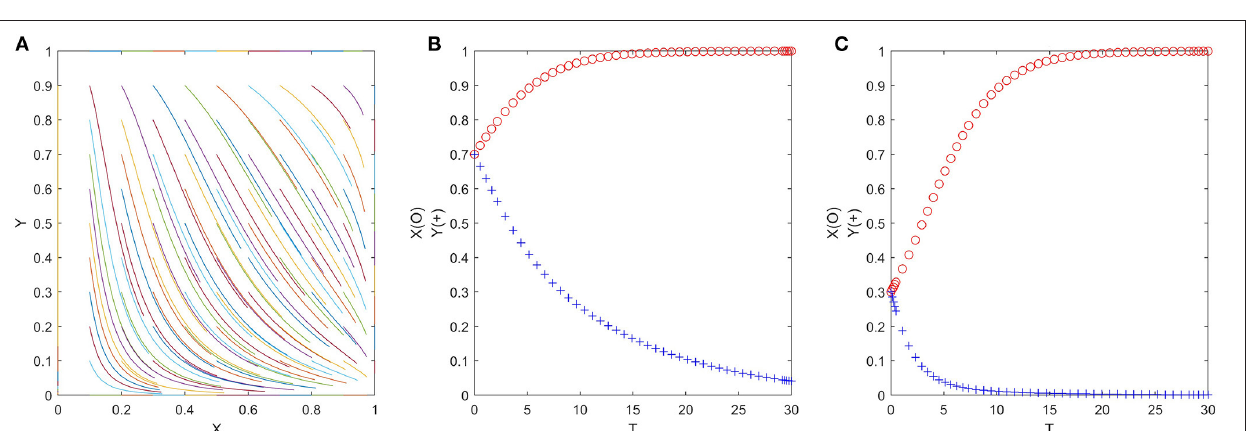
FIGURE 6 | (A–C) The evolution process of the official-folk game under unfavorable policy parameters (Scenario 7).